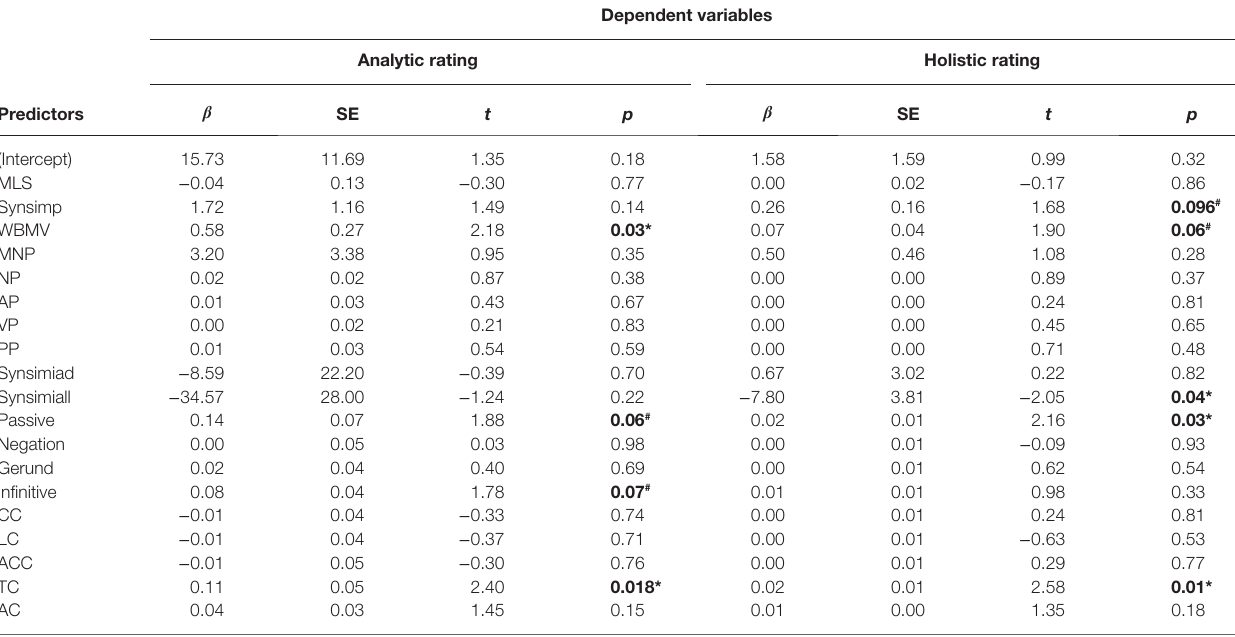
TABLE 4 | Linear regression in predicting writing quality assessed by human ratings.